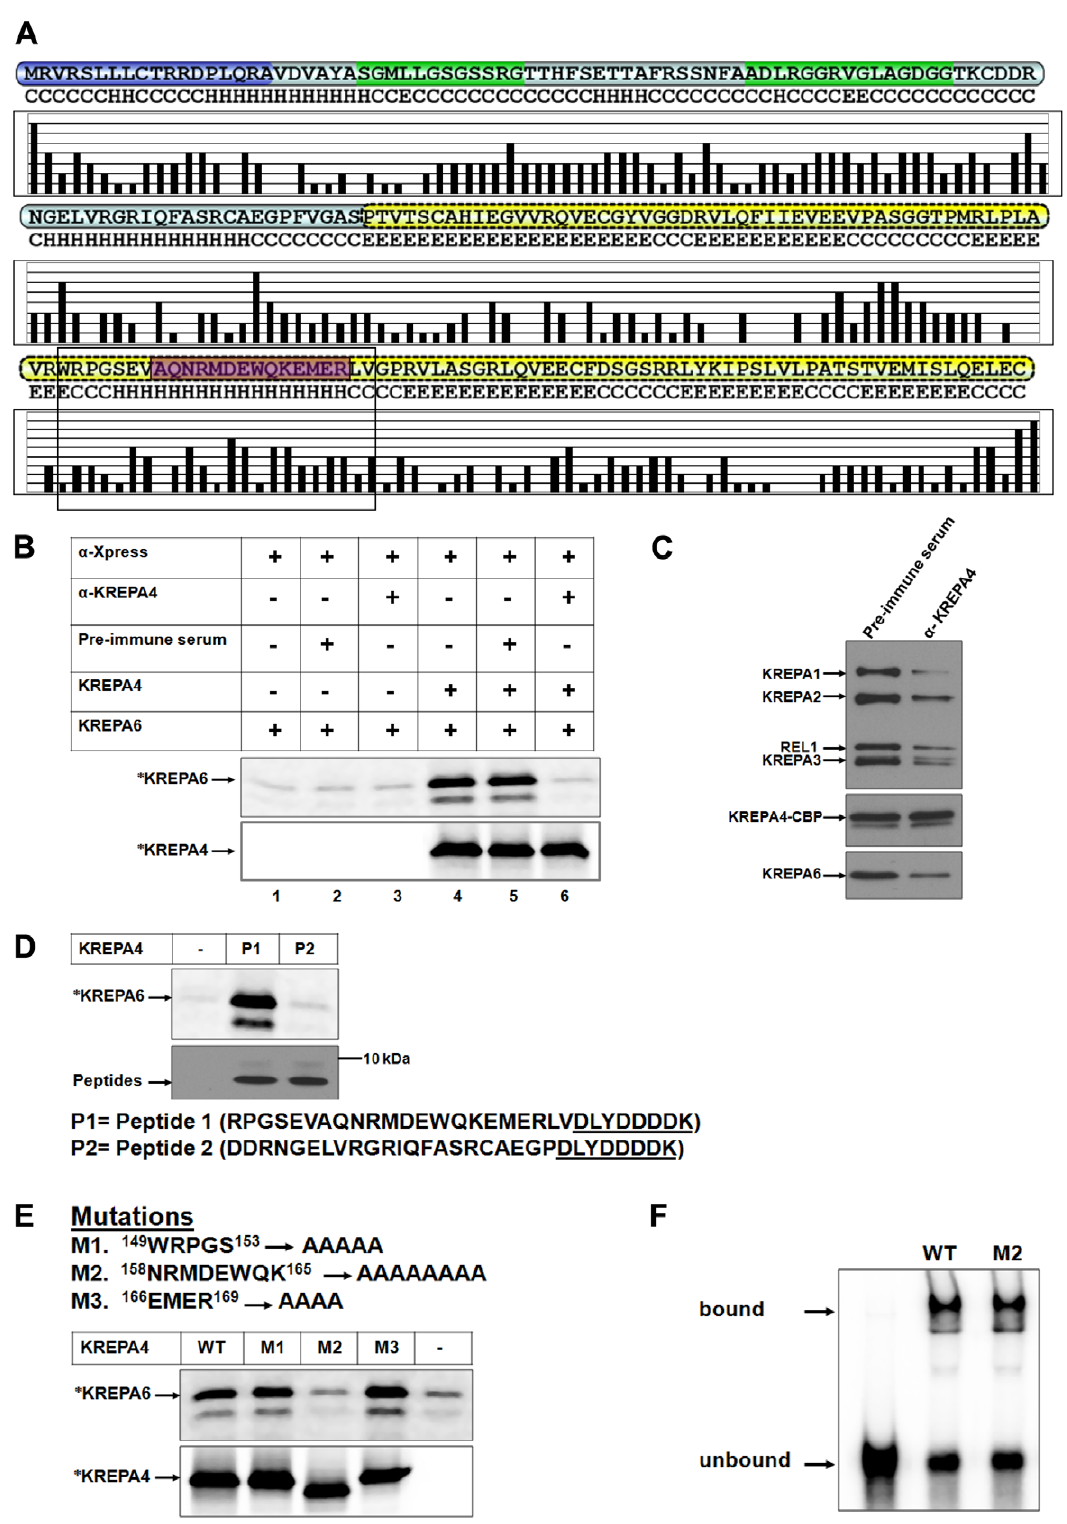
Figure 2. An antibody against the a -helix, or mutagenesis of this region inhibits the interaction with KREPA6. (A) Solvent accessibility prediction of residues in KREPA4 secondary structure. Higher bars indicate hydrophilic exposed residues while lower bars indicate hydrophobic buried residues. The a -helix of KREPA4 OB-fold, hypothesized to mediate interaction with KREPA6 is highlighted by a box. The peptide sequence used for generating anti-KREPA4 antibody is highlighted in purple. (B, upper panel) CoIP of 35 S-methionine labelled (*) KREPA6 with unlabelled full length KREPA4, using antibody against the KREPA4 Xpress tag ( a -Xpress). Table indicates the presence or absence of the a -KREPA4 antibody and the pre- immune serum, as well as whether proteins are present singly or mixed together. (B, lower panel) The amount of 35 S-methionine labelled (*) KREPA4